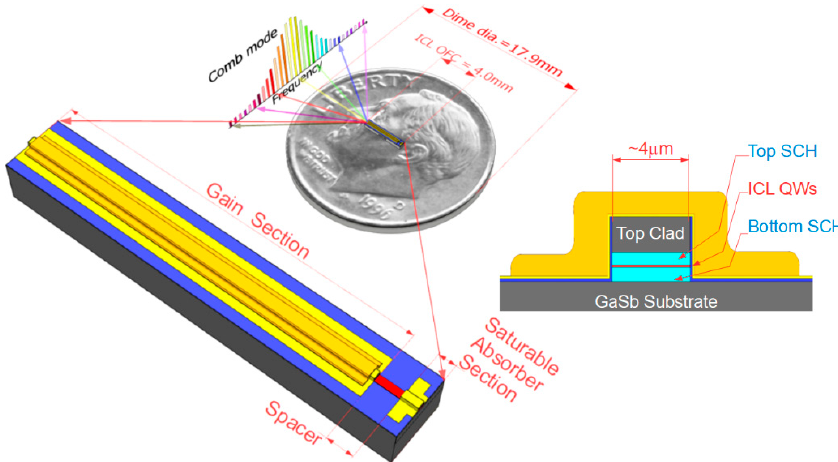
Figure 17. Schematic of an ICL frequency comb, with gain section, saturable absorber section, and uncontacted spacer layer to provide electrical isolation.